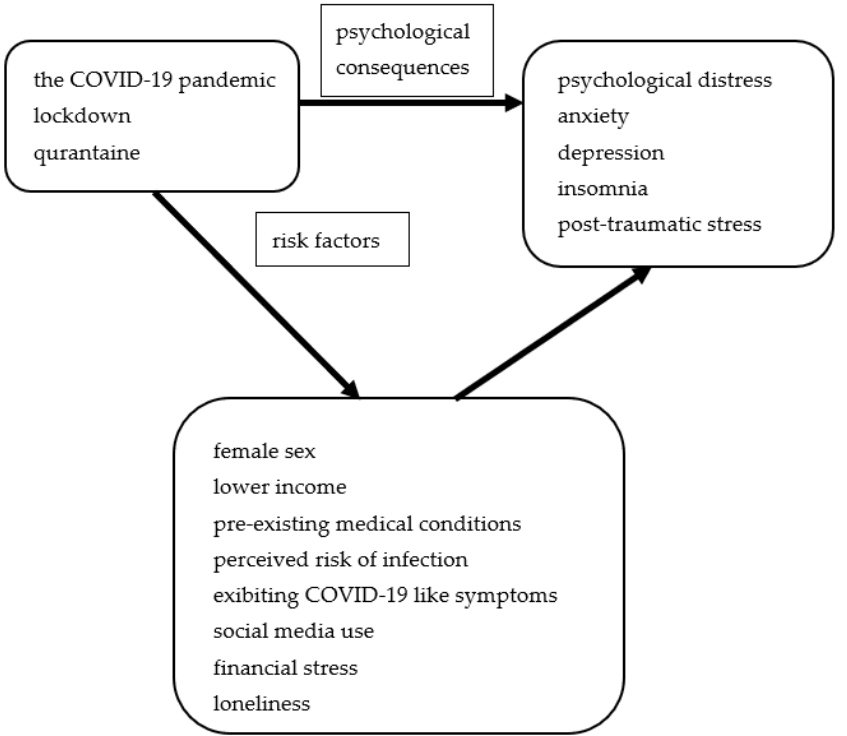
Figure 3. The main psychological consequences and their risk factors in adults. From a long-term public health perspective, the impact of the COVID-19 pandemic on the mental health of children and adolescents is particularly important because these disorders may have an impact on their development and future social functioning. In the developmental period, isolation from peers and family conflicts can have a great influence on the development of mental disorders. A meta-analysis of 15 studies including 22,996 children and adolescents demonstrated the occurrence of anxiety in 34.5%, depression in 41.7%, irritability in 42.3%, and inattention in 30.8%. In addition, 22.5% of children had a significant fear of COVID-19, 35.2% boredom, and 21.3% sleep disturbance during the first wave of the COVID-19 pandemic [40]. Moreover, a meta-analysis of 36 studies from 11 countries including 79,781 children and adolescents scored above risk thresholds for dis- tress, particularly anxiety and depressive symptoms in 18% to 60% of children and ado- lescents. In addition, in England sample factors associated with COVID-19 and lockdown contributed to 48% of suicides during lockdown [41]. Meanwhile, the meta-analysis of 23 studies from China and Turkey including 57,927 children and adolescents revealed the